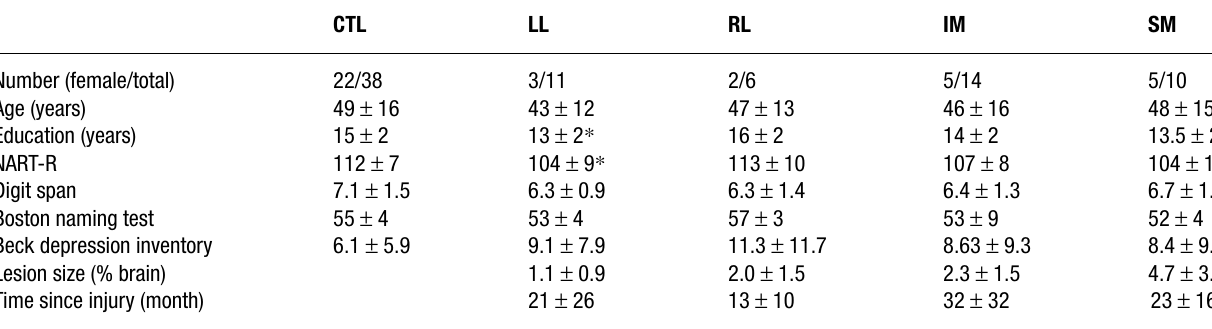
Table 2. Subject demographic and neuropsychological test data.